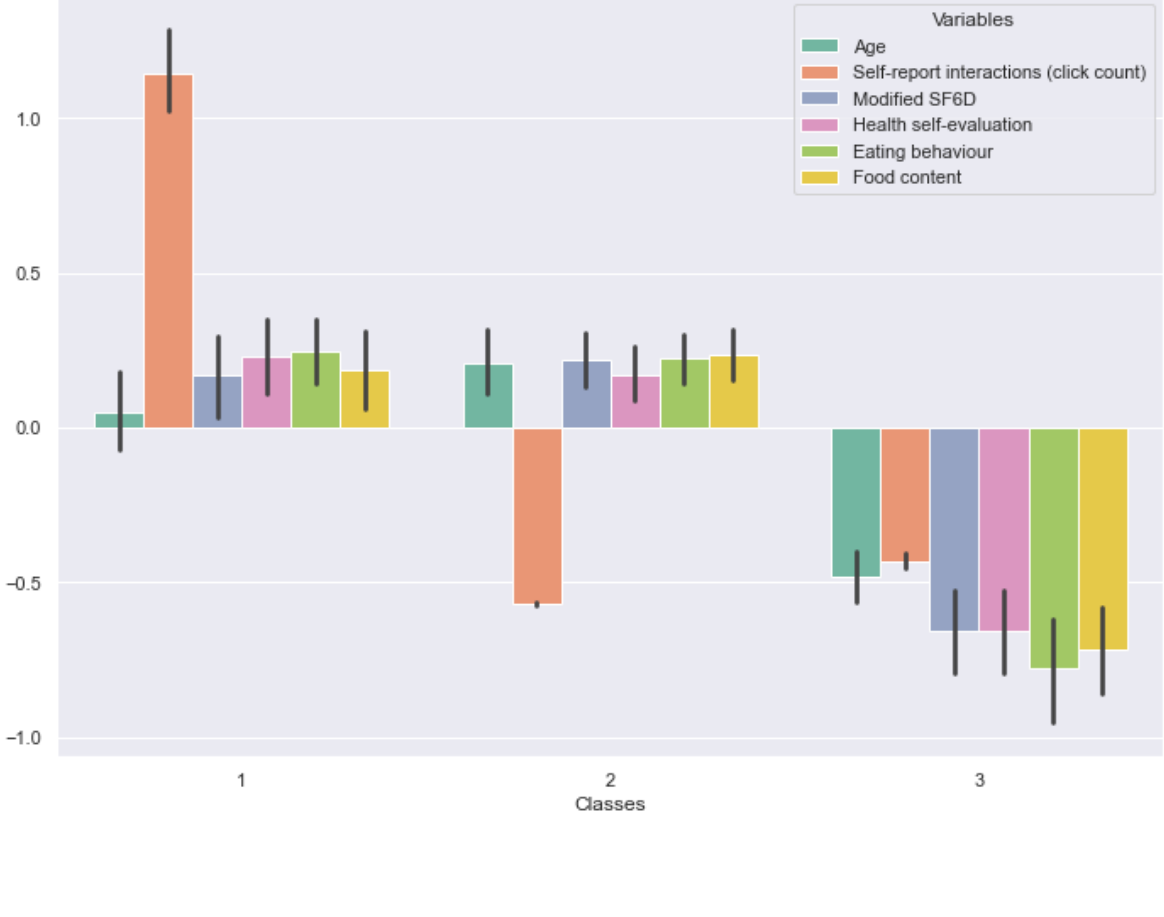
Figure 2. Classes identified in the latent profile analysis as described by the normalized